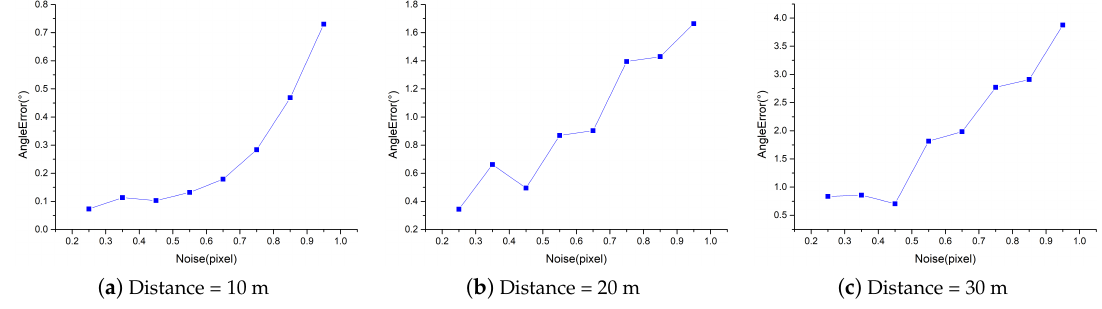
Figure 9. The error of the